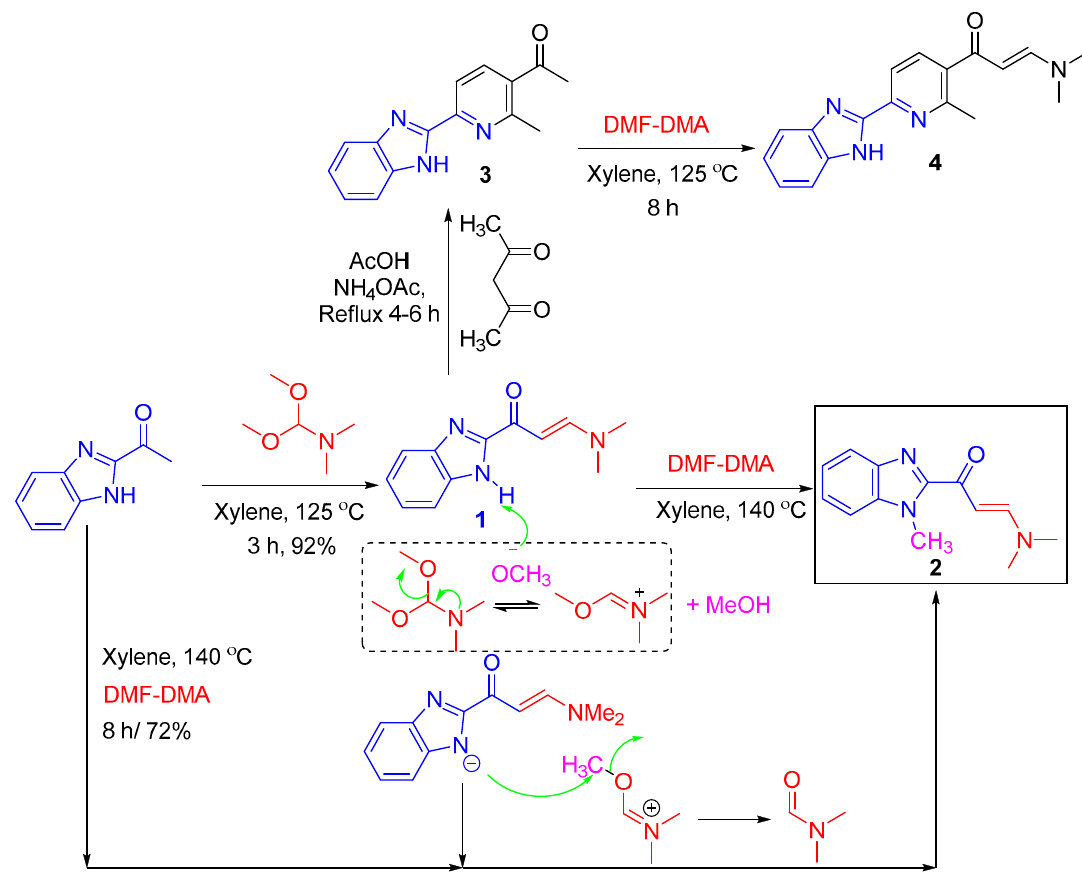
Table 1. Single crystal data and structure refinement